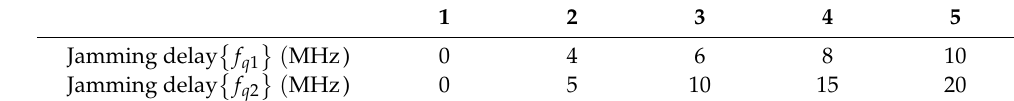
Table 2. Jamming frequency sequence.